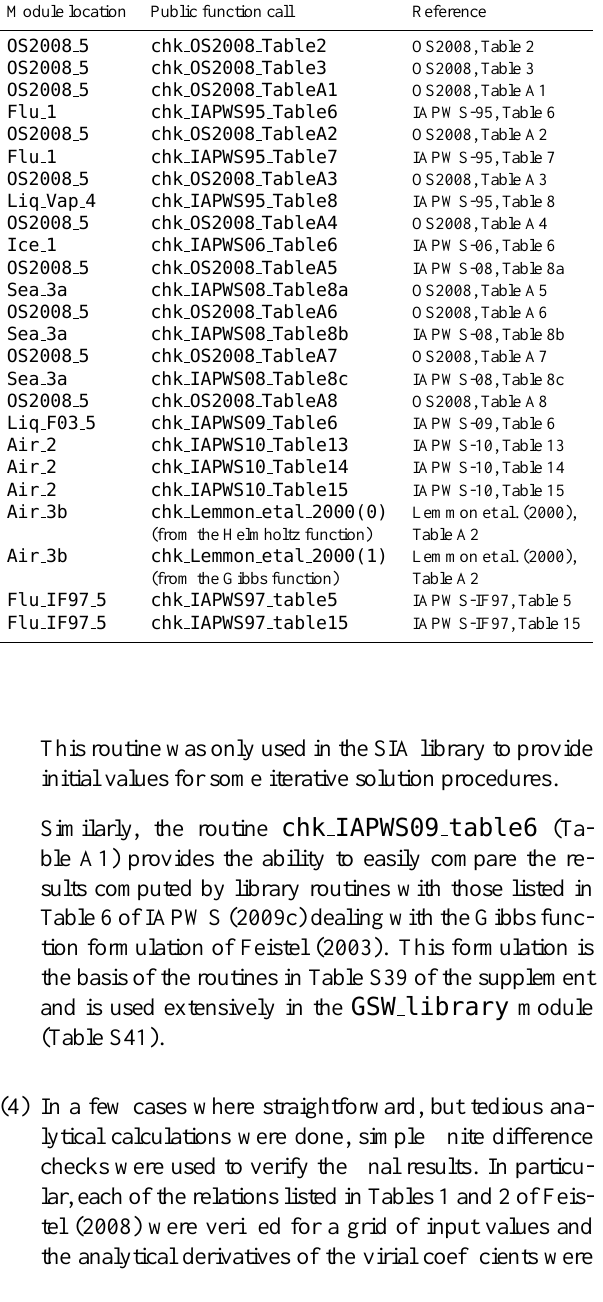
Table A1. Routines for comparison of the results from a local im- plementation with published check values. The functions are im- plemented in the modules where the function values are most nat- urally calculated. Several of the tables in module OS2008 5 also appear in IAPWS Releases. In these cases, the same tables may be obtained from the two different library routines (indicated by two different module names grouped together in the first column of this table to emphasize the connection). In Visual Basic, evaluating any of these functions will return formatted ASCII strings that may be printed to a window or saved to a file. In F ORTRAN , the results are written to standard output which may be redirected to any desired file. “OS2008” refers to Feistel et al.